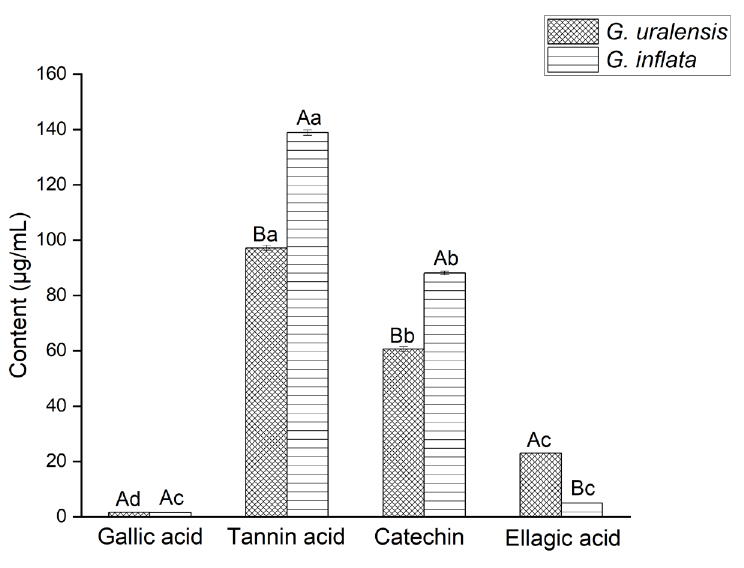
Figure 7. The content of four kinds of tannins in the leaves of two licorice ( Glycyrrhiza ) species. Different uppercase letters denote significant differences between means of the columns (P < 0.01), and different